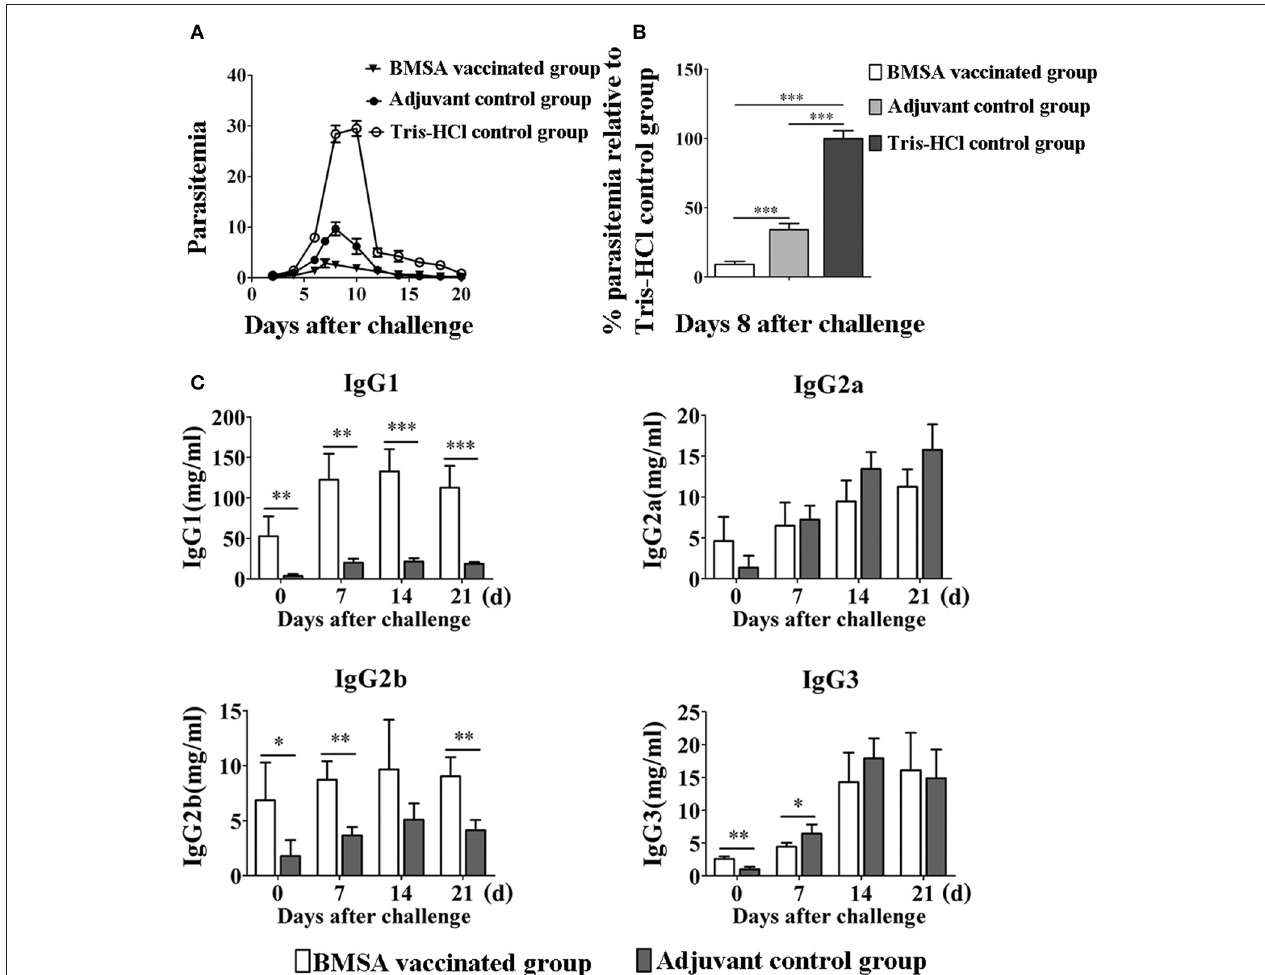
FIGURE 3 | Changes in parasitemia and levels of immunoglobulin G of BALB/c mice vaccinated with BMSA. BMSA vaccinated or adjuvant control group BALB/c mice were challenged with 1 × 10 7 erythrocytes infected with B. microti and were sampled on days 0, 7, 14, and 21. (A) Parasitemia was assessed every other day using flow cytometry (1,00,000 events). The data represent two individual experiments. (B) Parasitemia of the BMSA vaccinated group relative to the Tris-HCl control group on day 8 after challenge. (C) Levels of immunoglobulin G subclasses including IgG1, IgG2a, IgG2b, and IgG3 were detected using a Mouse Immunoglobulin Isotyping Magnetic Bead Panel (* p < 0.05; ** p < 0.01; *** p < 0.001). The data represent two individual